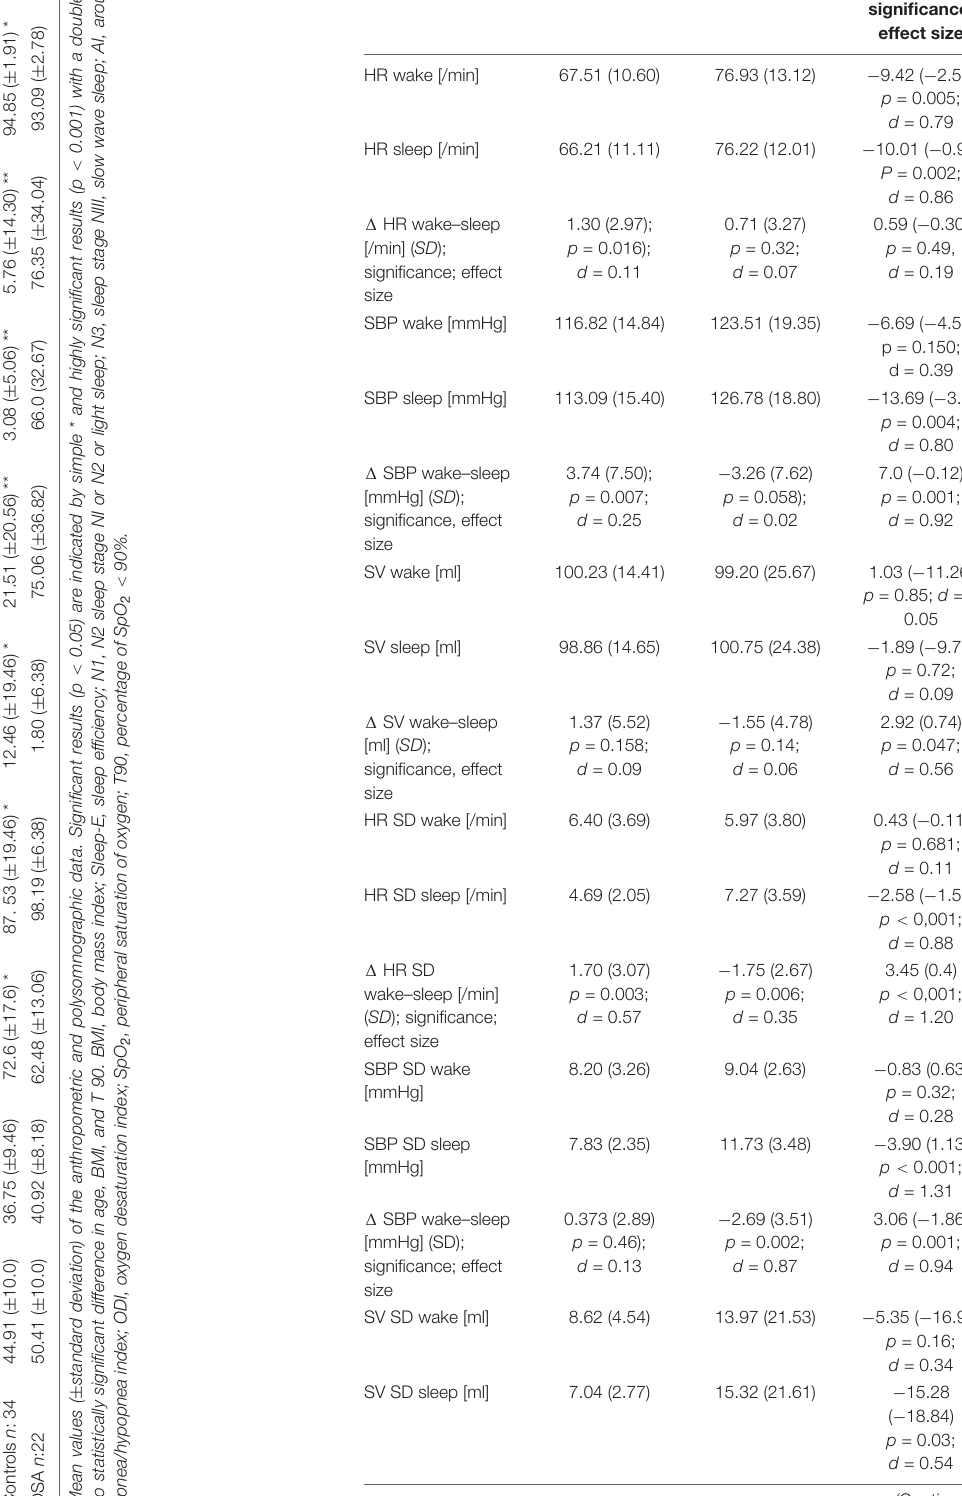
TABLE 2 | Student’s t -test and Cohen’s d : Hemodynamic parameters and its variation during wakefulness and sleep in controls and OSA patients. Controls ( SD ) ( n =